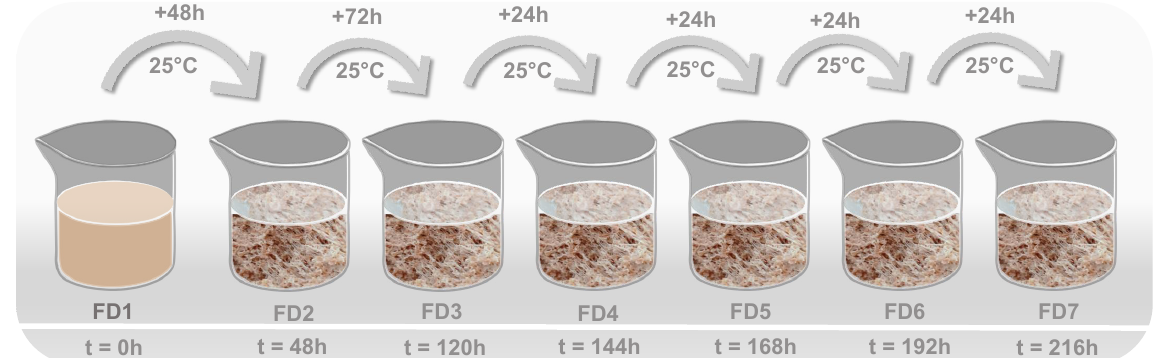
Figure 1. Backslopping to produce fermented dough from organic and conventional whole wheat flours. FD1, FD2, FD3, FD4, FD5, FD6, and FD7: fermented dough 0 h, 48 h, 120 h, 144 h, 168 h, 192 h, and 216 h of fermentation,